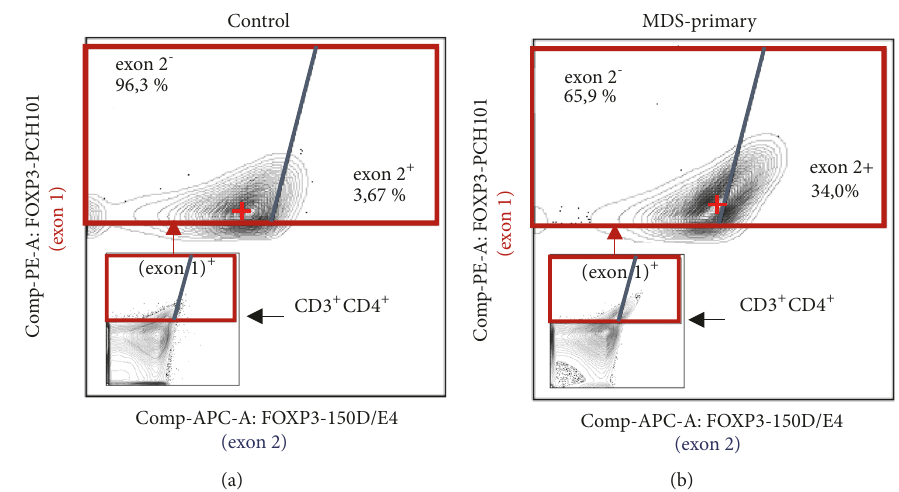
Figure 3: Flow cytometry. Contour plots reflecting FOXP3 exon 1 and exon 2 coexpression in CD3 + CD4 + cells (small plots) and CD3+4+FOXP3+ cells (large plots) from PBMC 1 of healthy age-matched donor (a) and primary patient with MDS (b). The red cross marks the medians of the corresponding fluorescent intensities in the total FOXP3 + gate. 1 PBMCs: peripheral blood mononuclear